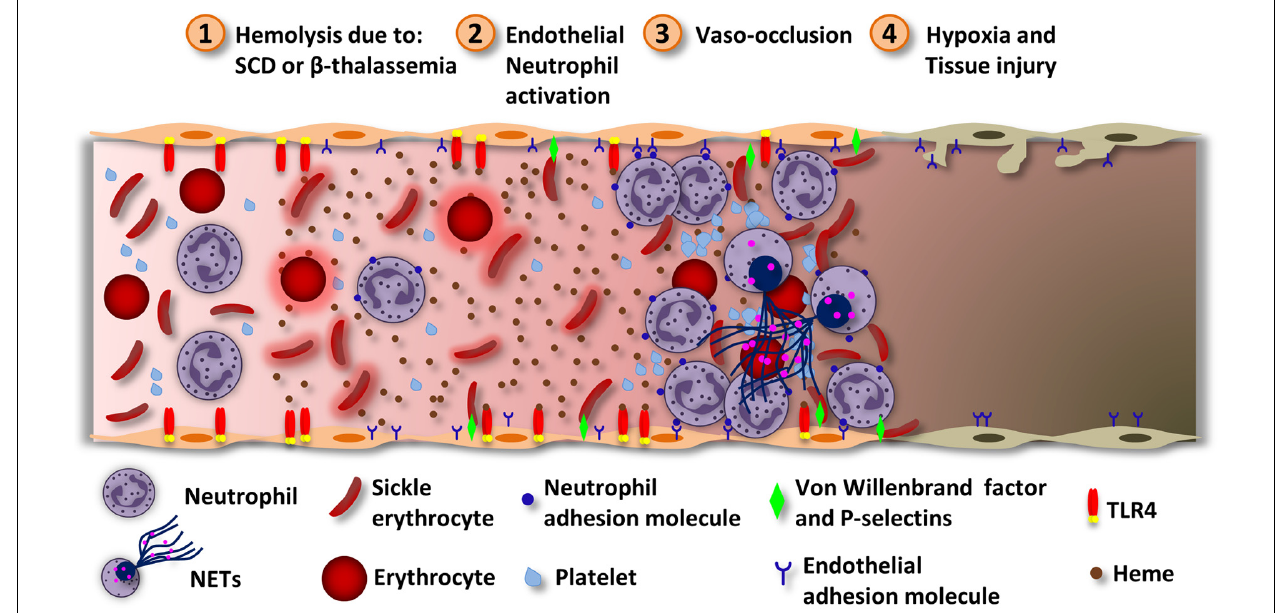
FIGURE 4 | Heme induces vascular inflammation in hemolytic diseases. During intravascular hemolysis the serum proteins responsible for removing heme get saturated and heme can exert its inflammatory effects. (1) Hemolysis can happen due to ischemia/reperfusion, SCD or β -thalassemia. While in SCD, Hb polymerization alters erythrocytes physically, in β -thalassemia the accumulation of α -globin aggregates inside the erythrocytes. In both cases, the erythrocytes became more susceptible to hemolysis. Hemolysis increases the concentration of Hb which, under oxidative stress, releases free heme. (2) Heme activates neutrophils and endothelial cells, by ROS generation. In both cells, heme induces the expression of complementary adhesion molecules. In endothelial cells, heme induces TLR4-dependent degranulation of Weibel–Palade bodies and P-selectins and VWF release. The VWF